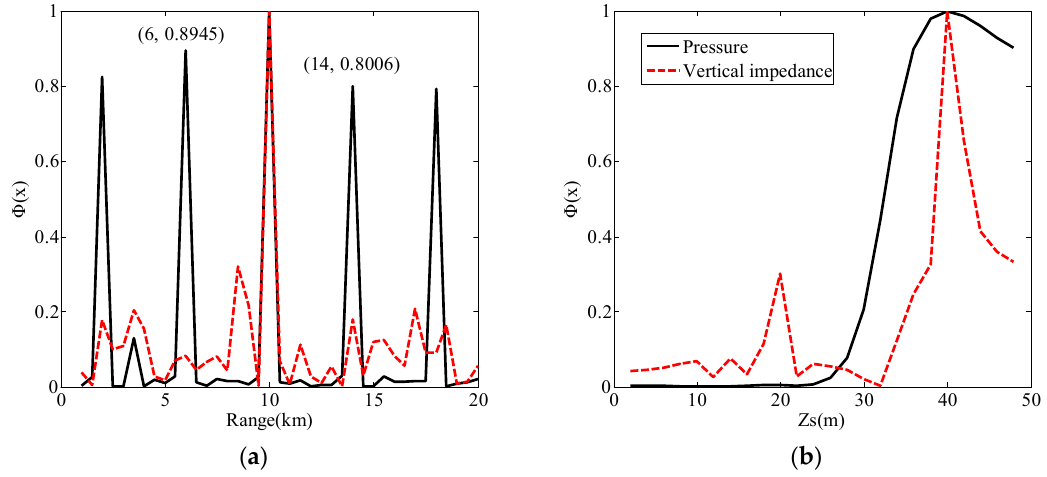
Figure 10. Normalized objective function curves. ( a ) Normalized objective functions for the range when the measured vector was the pressure (black line) and the vertical wave impedance (red dotted line); ( b ) normalized objective functions for source depth when the measured vector was the pressure (black line) and the vertical wave impedance (red dotted